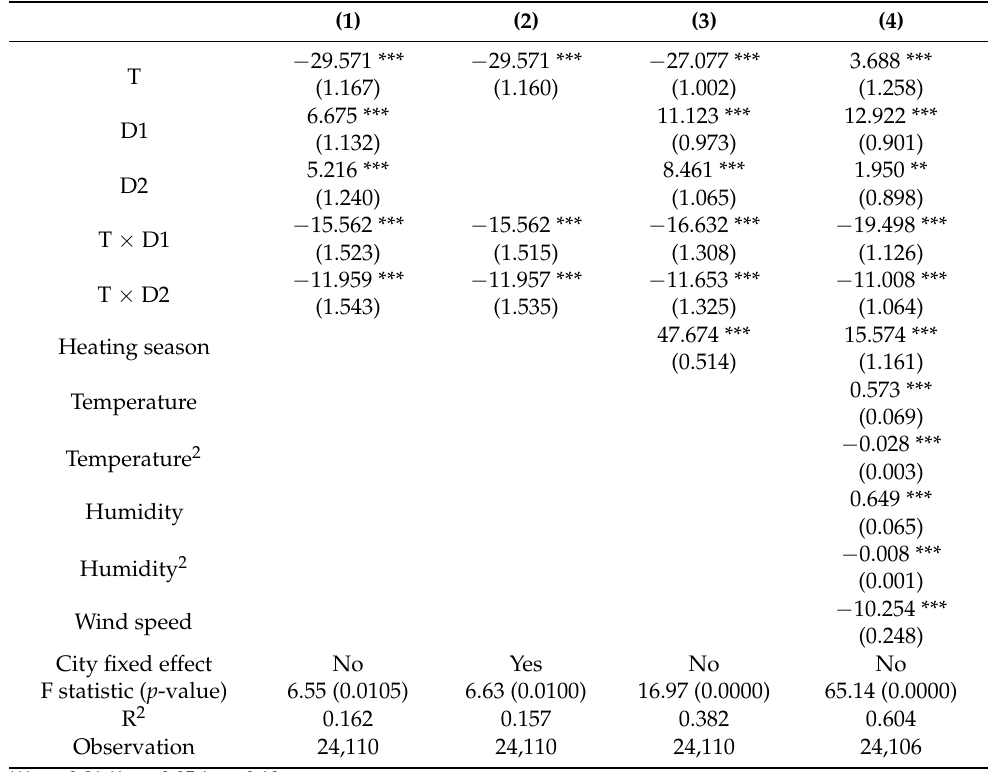
Table 2. Regression results: Two treatment groups.